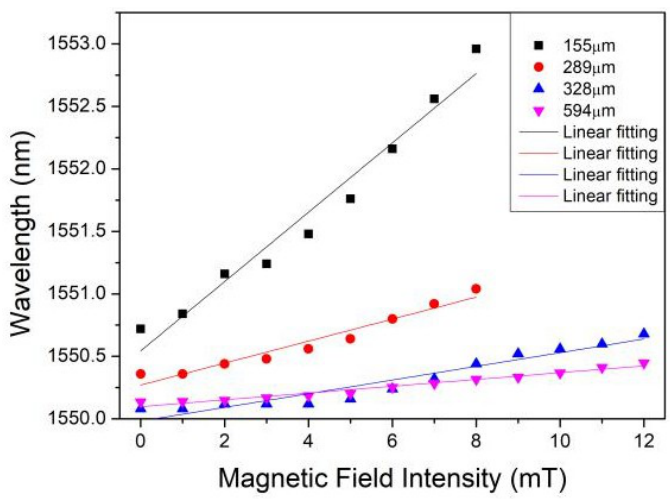
Figure 4. Wavelength shift as a function of magnetic field for the MKR sensors. The ring diameters of the MKRs are 155 µ m ( a ), 289 µ m ( b ), 328 µ m ( c ), and 594 µ m ( d ).